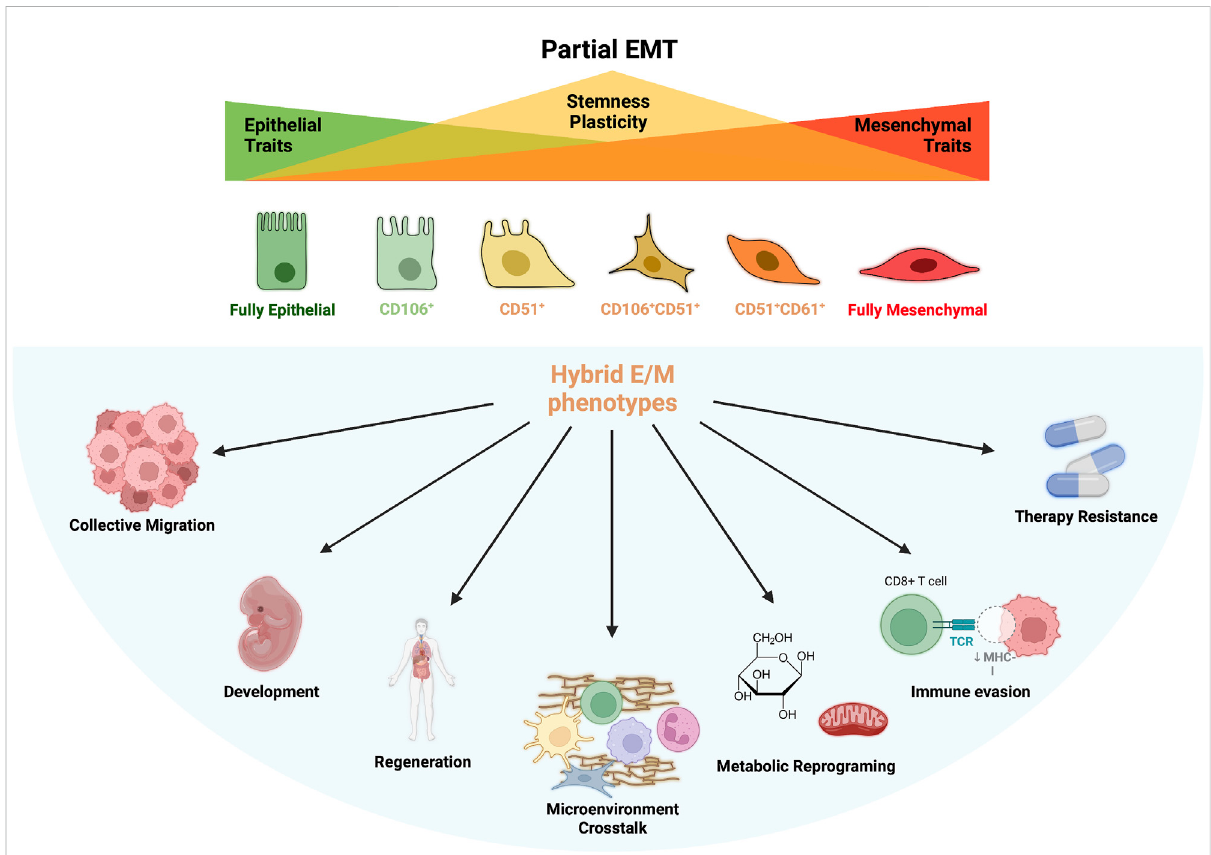
FIGURE 1 PartialEMTandHybridE/MPhenotypes.DuringpartialEMTaregeneratedseveralintermediatedphenotypeswhichbearmixedepithelial(E)and mesenchymal(M)features.ThesestatesarecalledhybridE/MphenotypeanddisplayparticularsurfacemarkerssuchasCD106,CD51andCD61.The loss of E phenotype coincides with an increase of stemness and plasticity that reaches its peak during the formation of hybrid states and decrease again when EMT is complete. Plasticity and stemness are at the base of hybrid cells peculiar features: collective migration, development and differentiation, regeneration, microenvironmental organization, metabolic plasticity, immune evasion, immune suppression and therapy